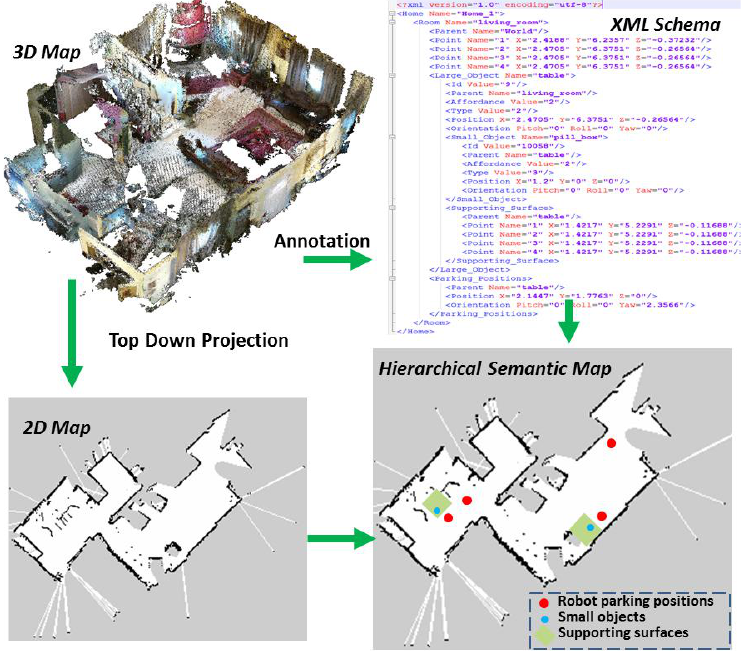
Figure 3. The pipeline for the formulation of the hierarchical semantic